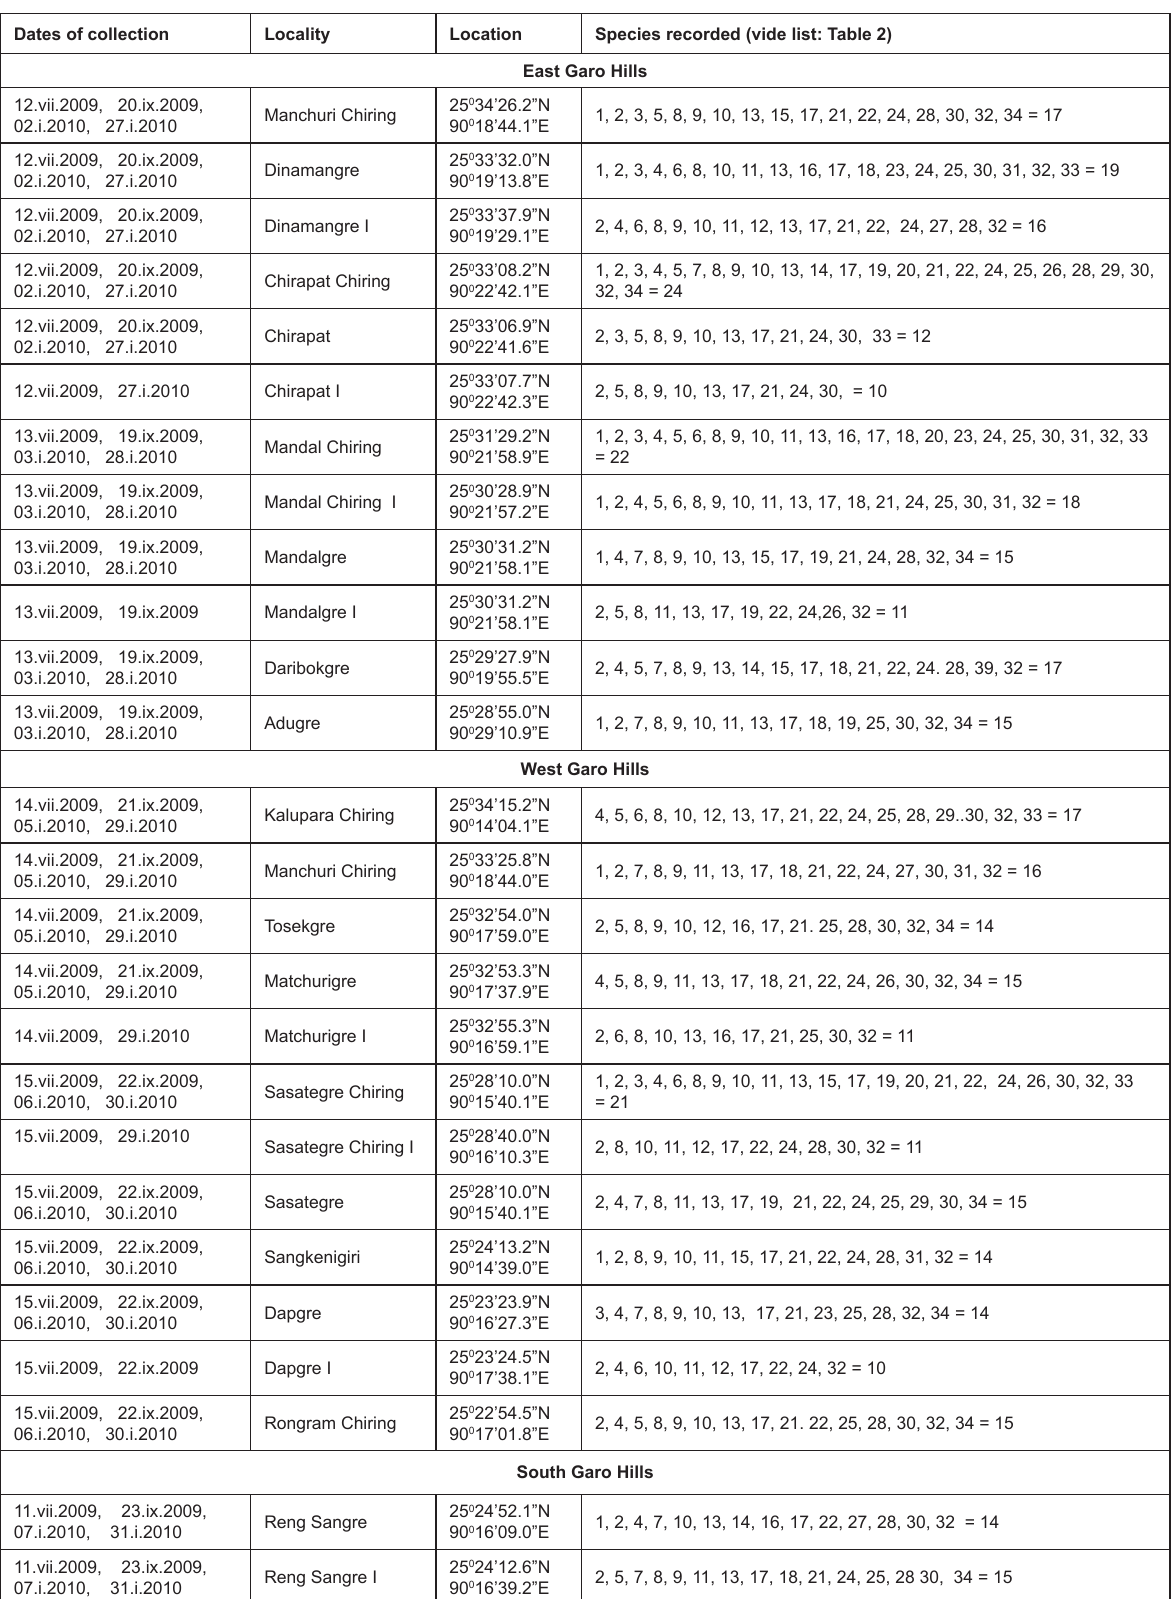
Table 1. List of the sampled localities Dates of collection Locality Location Species recorded (vide list: Table